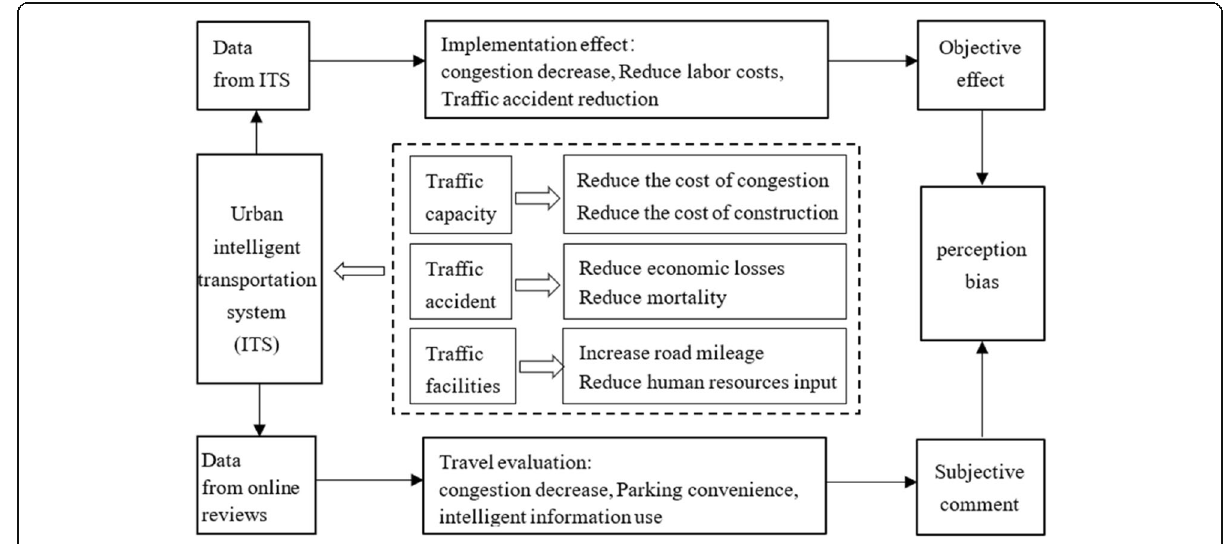
Fig. 1 Perception bias in intelligent transportation